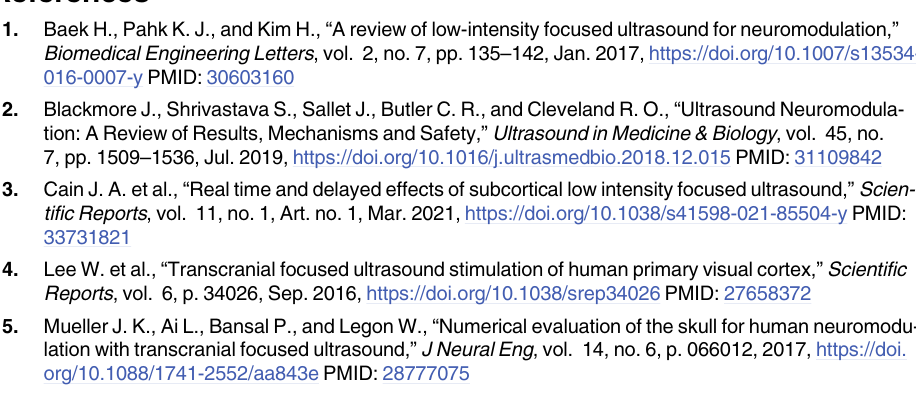
S1 Table. Convergence test. CFL’s of 0.1, 0.2, and 0.3 were used while PPW was varied between 3 and 6 by doubling dimensions of the simulation space for half of the simulations. All other parameters were held constant at 1 MHz Fundamental frequency, 12mm Bone thick- ness, 90 degrees trajectory (flat against bone), 80mm transducer depth and 80mm transducer width. The attenuation and refraction across this smaller parameter space is